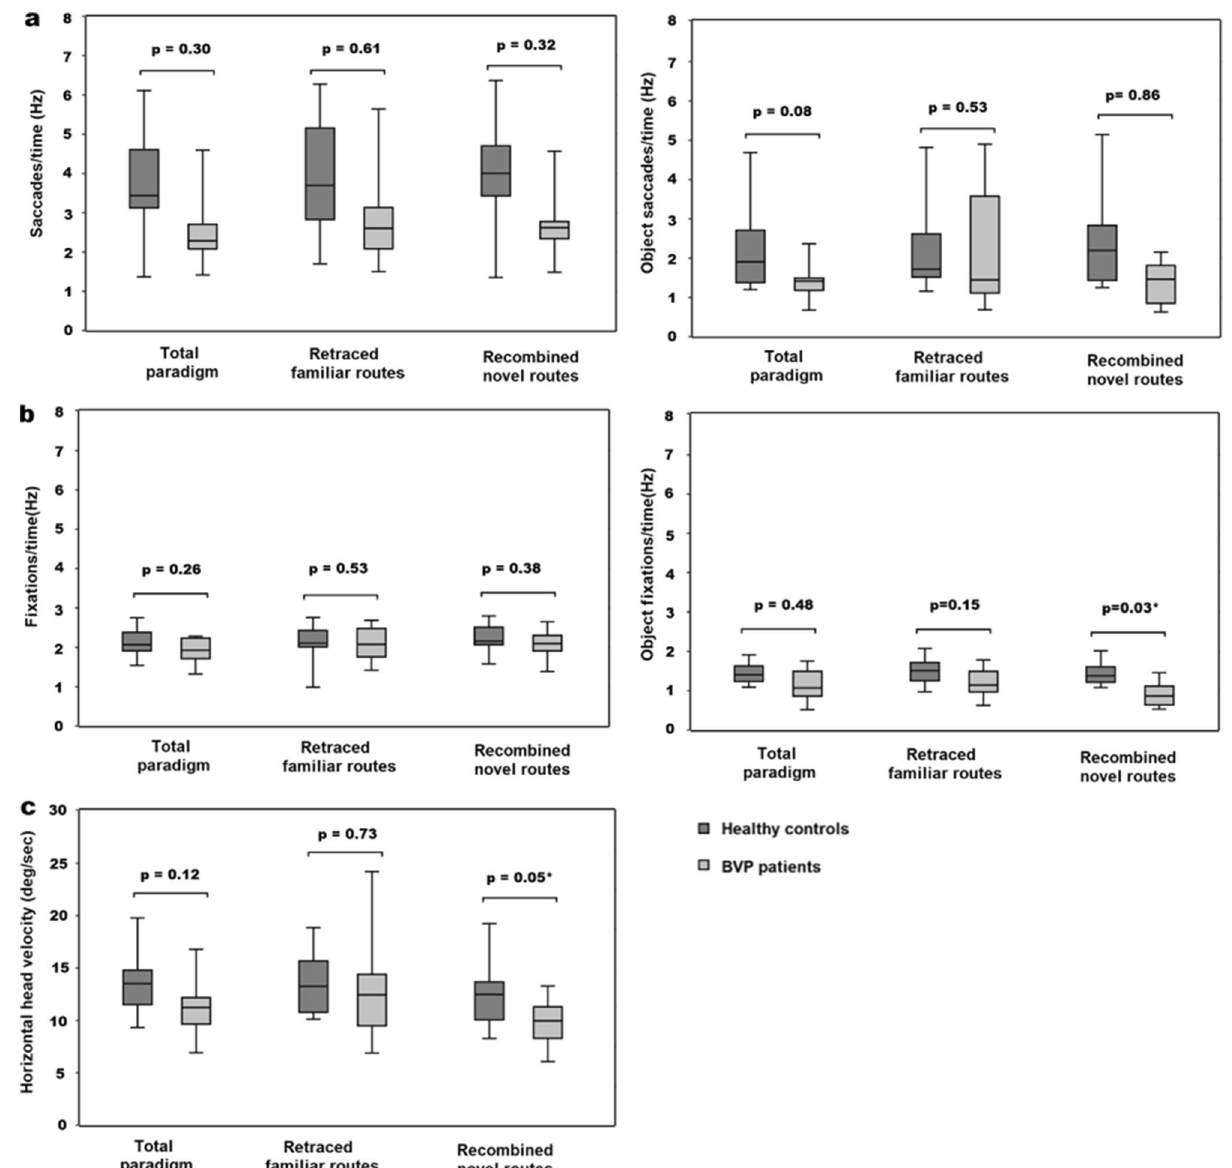
Figure 4. Eye and head movement parameters in healthy controls and patients with BVP. ( a ) Number of saccades/time (Hz) (total, retraced familiar routes, recombined novel routes) did not differ between BVP and HC. Number of saccades/time (Hz) (total, retraced familiar routes, recombined novel routes) towards objects feasible as landmarks also did not differ between BVP and HC. ( b ) Number of fixations/time (Hz) (total, retraced familiar routes, recombined novel routes) did not differ between BVP and HC. Number of object- specific fixations/time (Hz) when recombining novel routes was significantly lower in the BVP, while object- specific fixations in total and on retraced familiar routes were comparable between BVP and HC. ( c ) Horizontal head velocity (deg/s) was lower in BVP, when recombining novel routes, and similar when retracing familiar between both groups. The values are depicted as Tukey plots, respectively. BVP: bilateral vestibulopathy, deg: degree, HC: healthy controls, Hz: